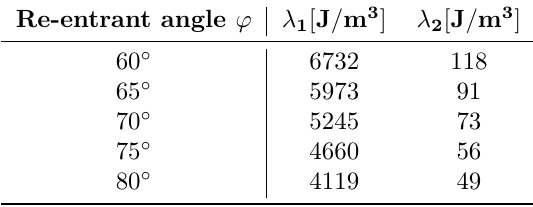
Table 2. Deformation energy density of RVE